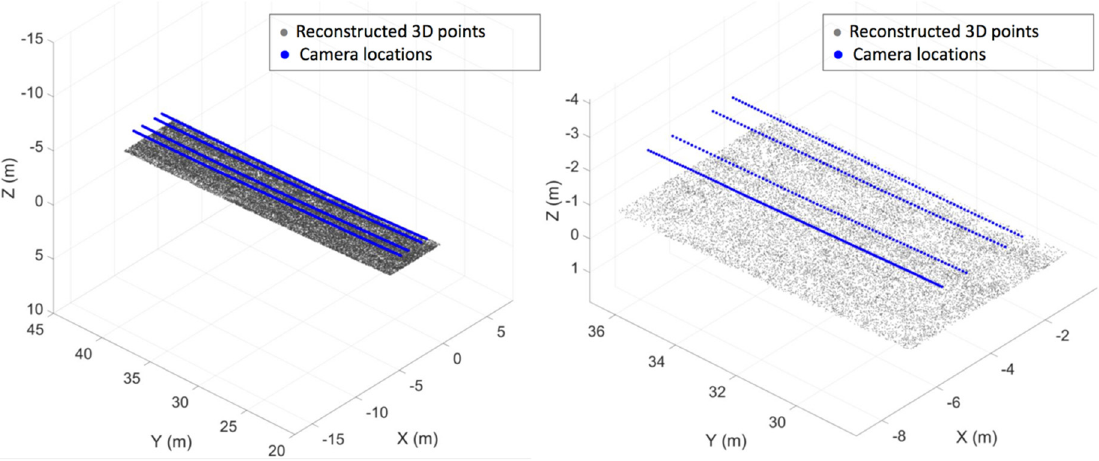
Figure 12. The reconstructed camera pose of all camera sequences and reconstructed 3D points (left image: zoom-out, right image: zoom-in).